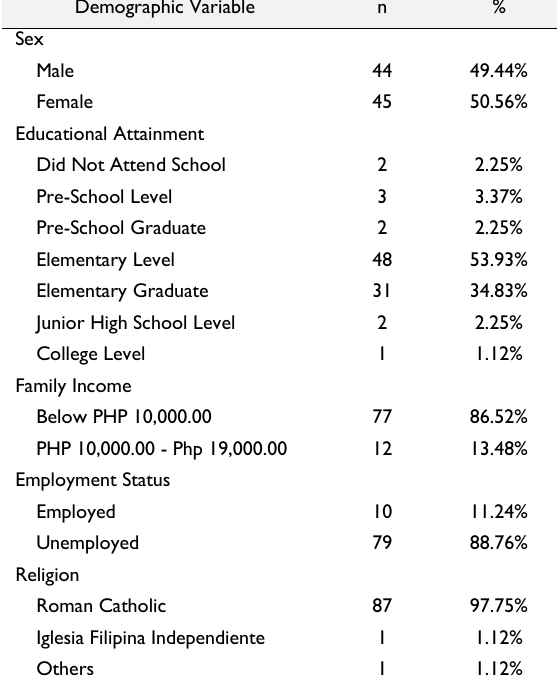
Table 1 Socio-demographic profile of the older adults